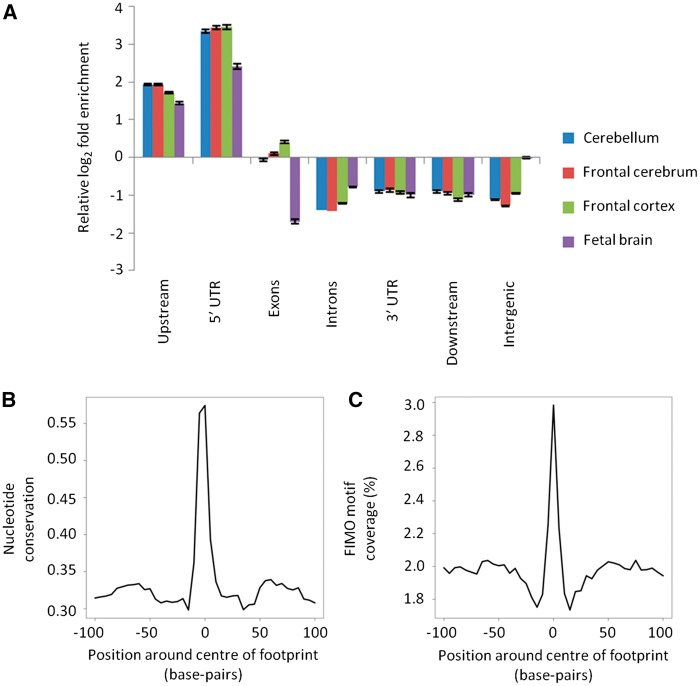
Functional annotation of Wellington DNase-seq footprints. Panel (A) shows relative enrichment of footprint-containing DHS to DHS without footprints for different metagene regions. Error bars show the standard deviation of log2 fold enrichment. Density plots of (B) FIMO motif coverage and (C) nucleotide conservation score within mammalian species (PhyloP46way) around all brain footprints combined.